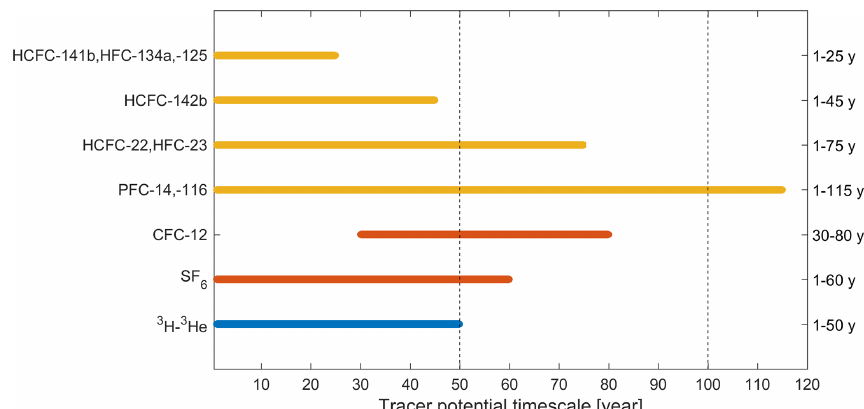
Figure 1. Seawater timescales (“tracer age ranges”) of potential chronological transient tracers (selected HCFCs, HFCs, and PFCs; yellow) and traditional chronological transient tracers (CFC-12 and SF 6 ; red) combined with radioisotope dating using radioactive transient tracers ( 3 H– 3 He; blue). Tracer age ranges of chronological transient tracers are approximately estimated from Fig. 6 (see below), while those of radioactive transient tracers are from Aggarwal